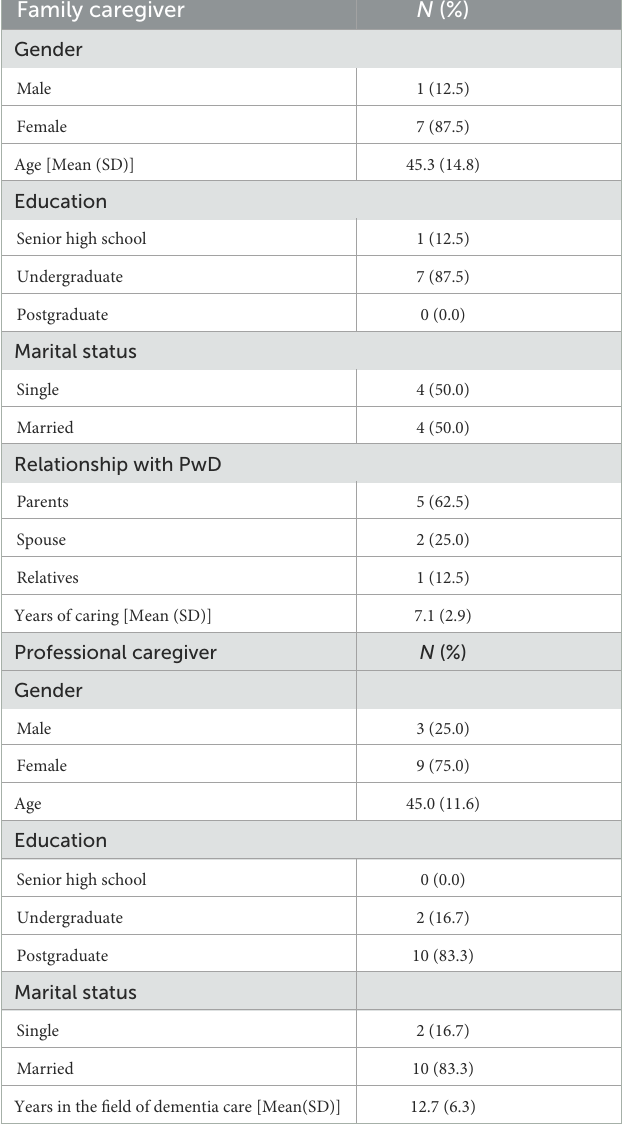
TABLE 1 Socio demography characteristics of FGD